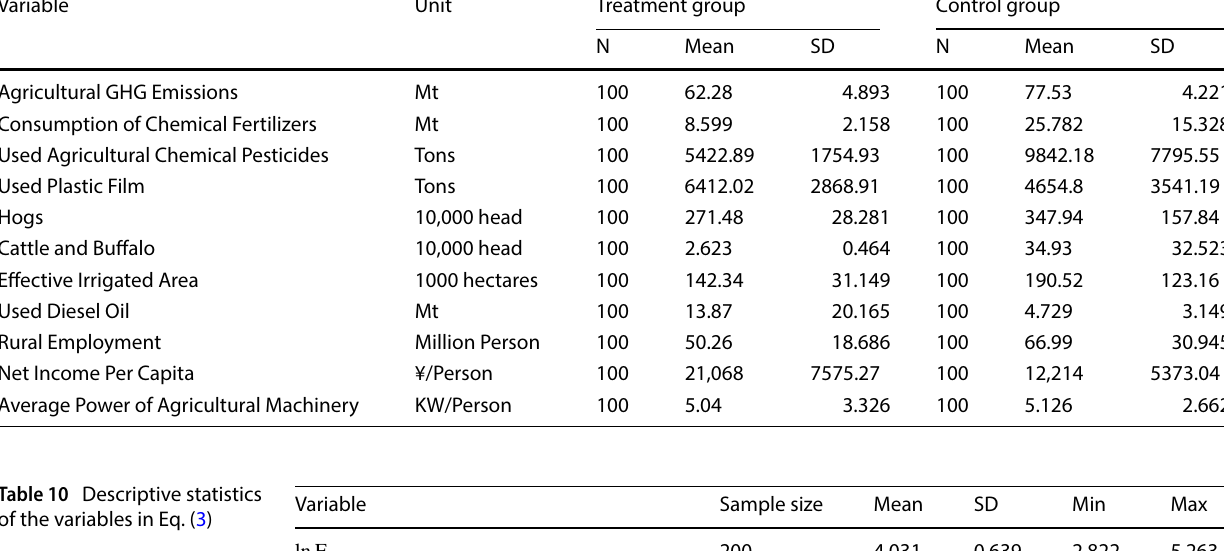
Table 9 Definitions of variables